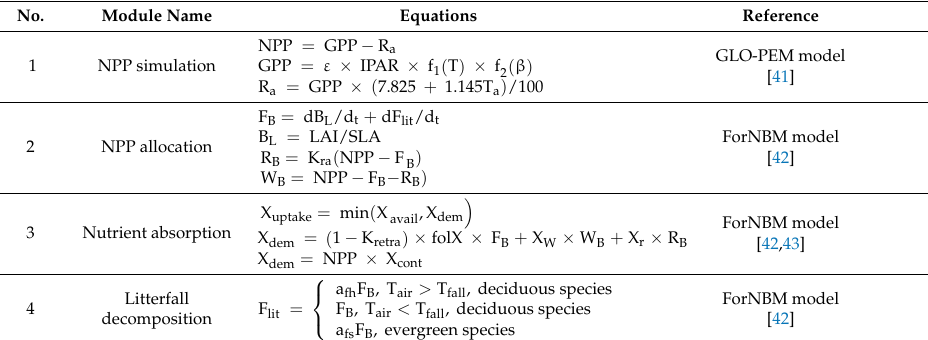
Table 1. Functions and parameters related to N and P uptake in the RIPAM